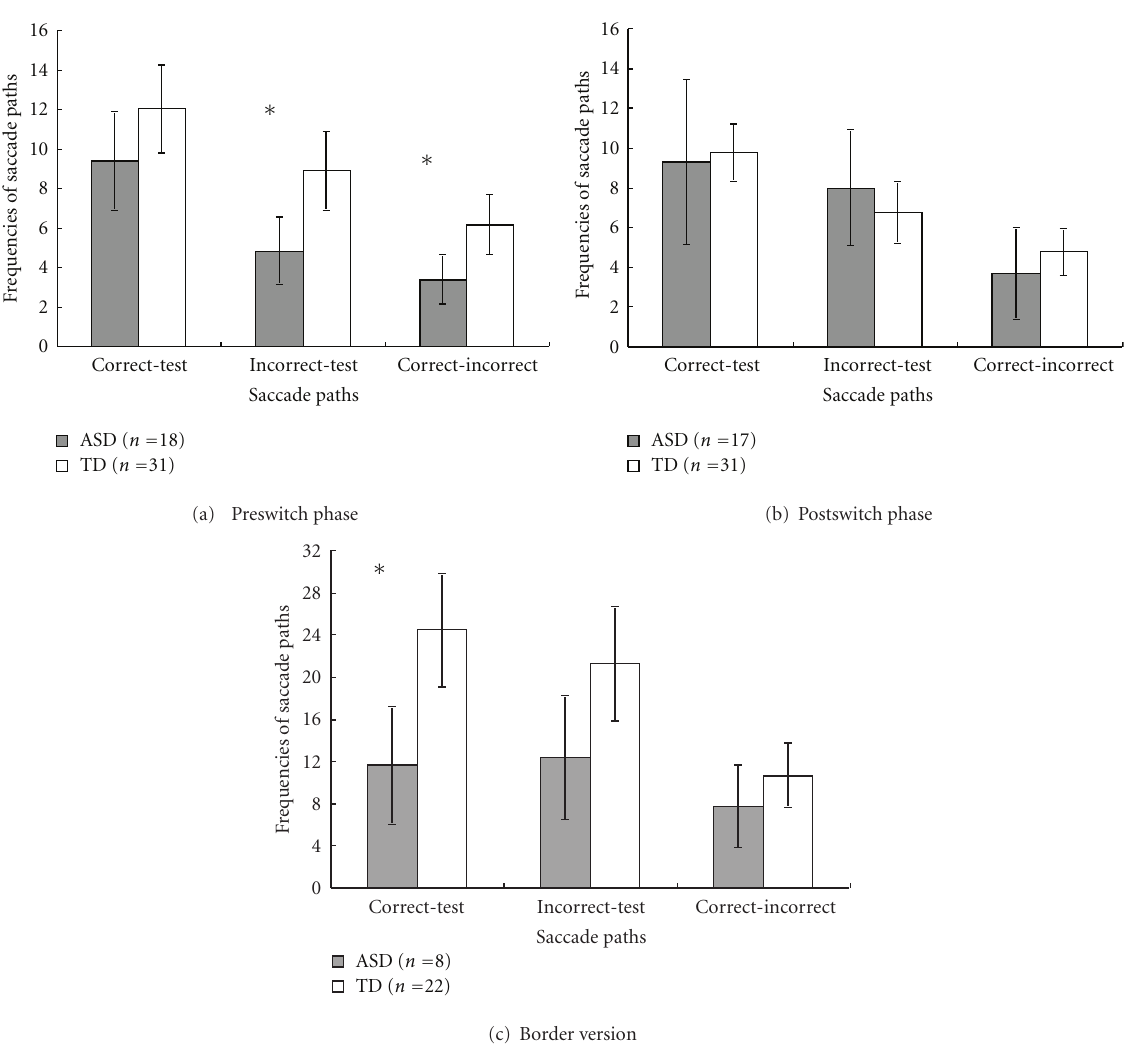
Figure 3: Frequencies of the correct-test, the incorrect-test, and the correct-incorrect paths for ASD and TD children during the preswitch phase (a), the postswitch phase (b), and the border version (c). (Error bars represent 95% confidence intervals). ∗ P < .